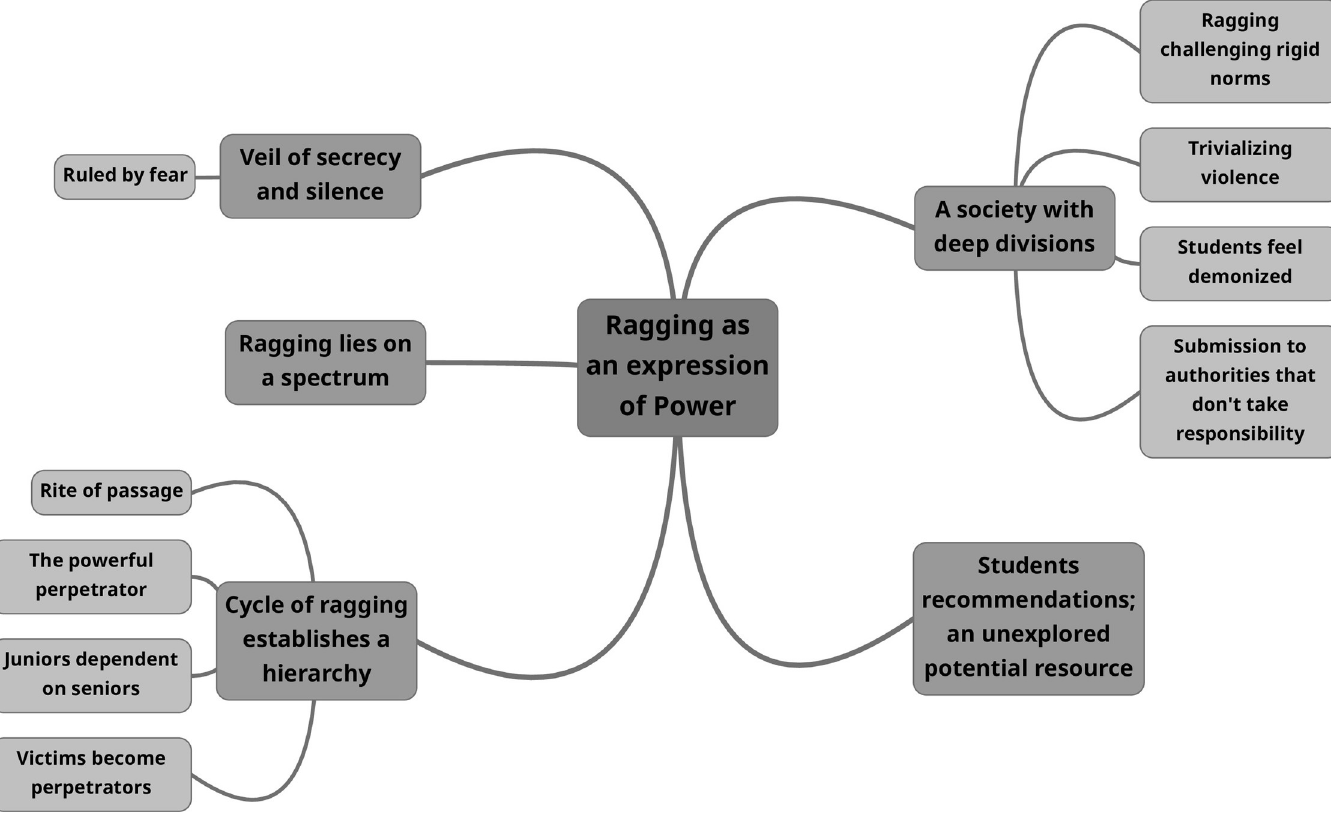
PLOS ONE | https://doi.org/10.1371/journal.pone.0271087 July 11,